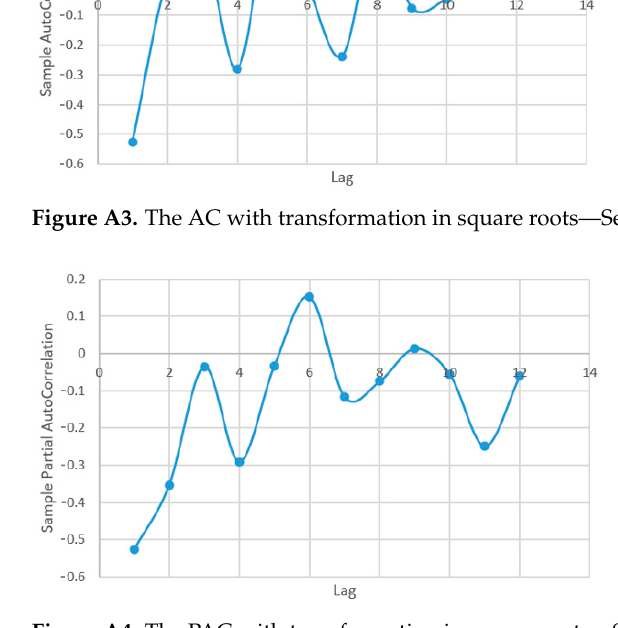
Figure A4. The PAC with transformation in square roots—Series B.